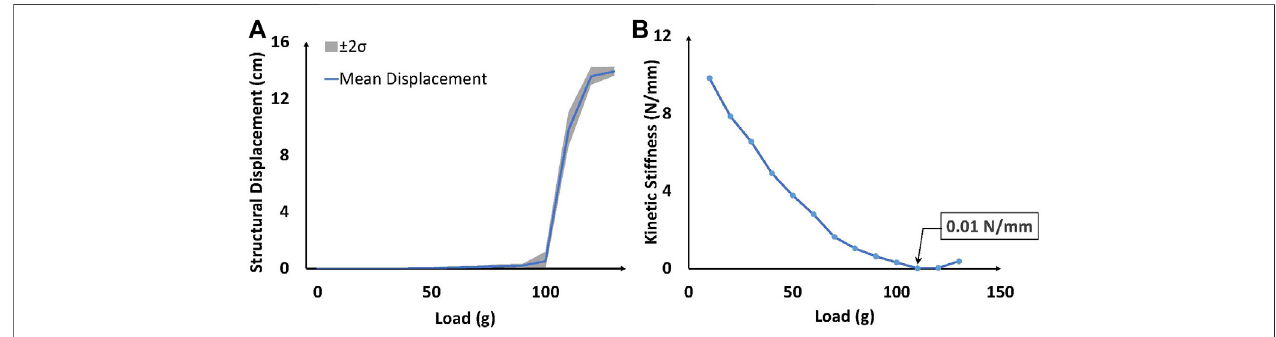
FIGURE11|(A) Plot forstructuraldisplacement(cm) vs. load(g) applied for theOPB experimental model. The continuous blue linerepresentsthe mean structural displacement and the gray regionshows the area enclosed under twostandard deviations on either side ofthemeandisplacement. (B) Kinetic stiffness (N/mm) vs. load (g) plot for the OPB model showing the non-linear decrease in effective stiffness to a minimum of 0.01 N/mm.